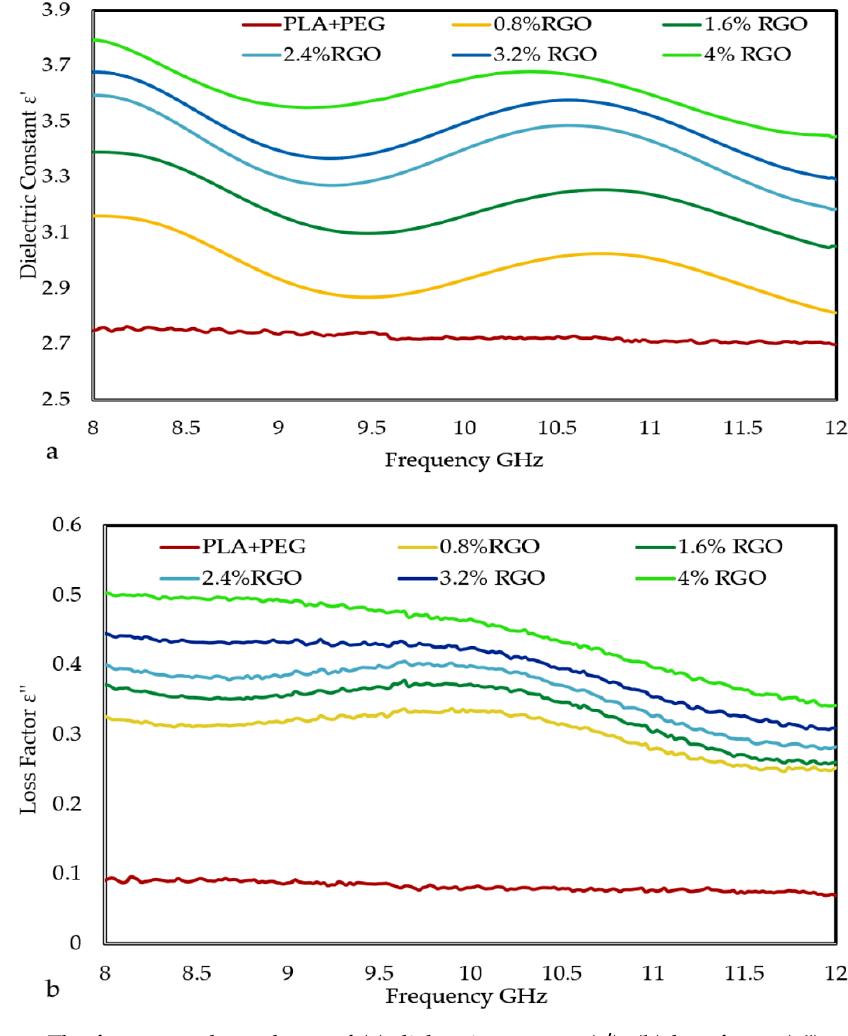
Figure 11. The frequency dependence of ( a ) dielectric constant (ε′ ), ( b ) loss factor (ε″ ) at various RGO loadings.